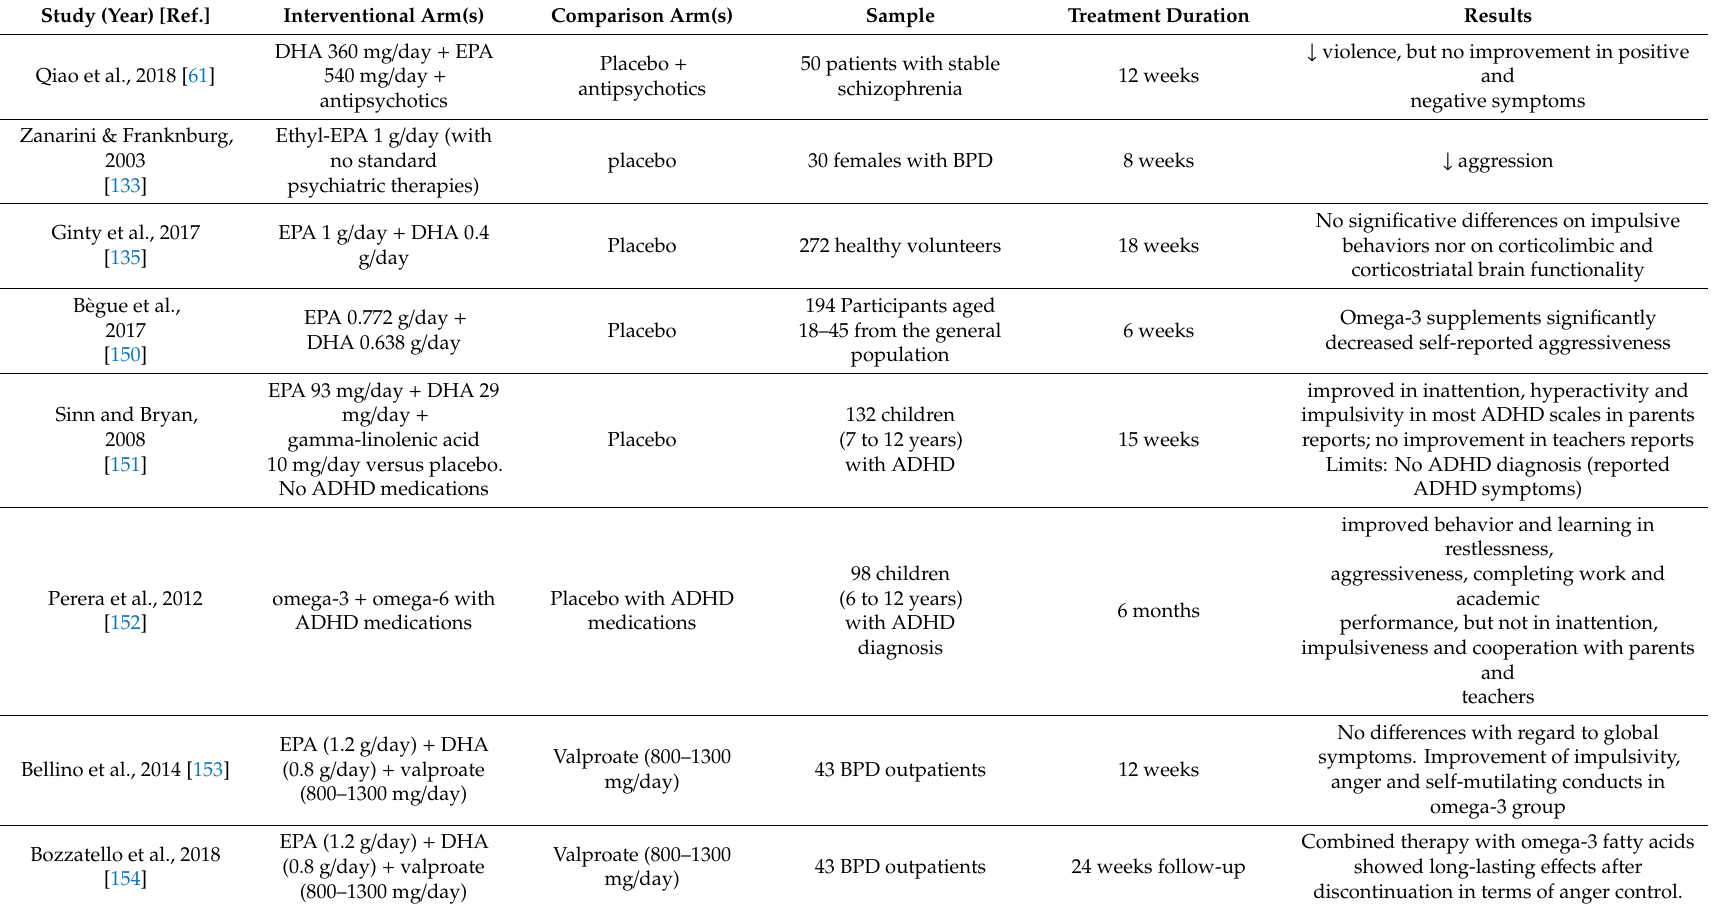
Table 3. Randomized controlled trials and open trials of omega-3 PUFAs on impulsivity and